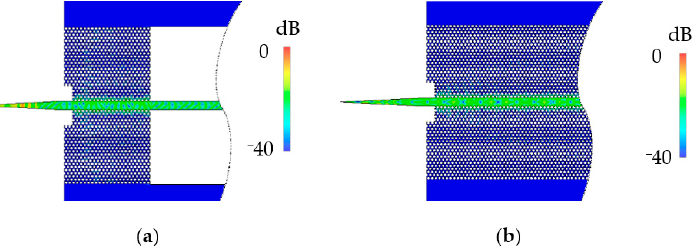
Figure 2. Electric field distribution at 0.925 THz: ( a ) Unclad waveguide; ( b ) EM waveguide.